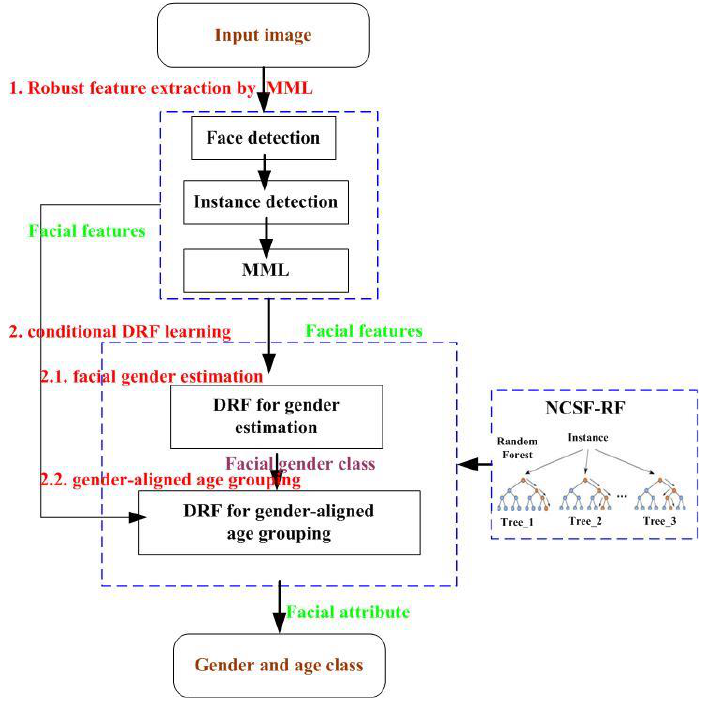
Figure 2. Flowchart of the proposed approach for facial gender and age classification.